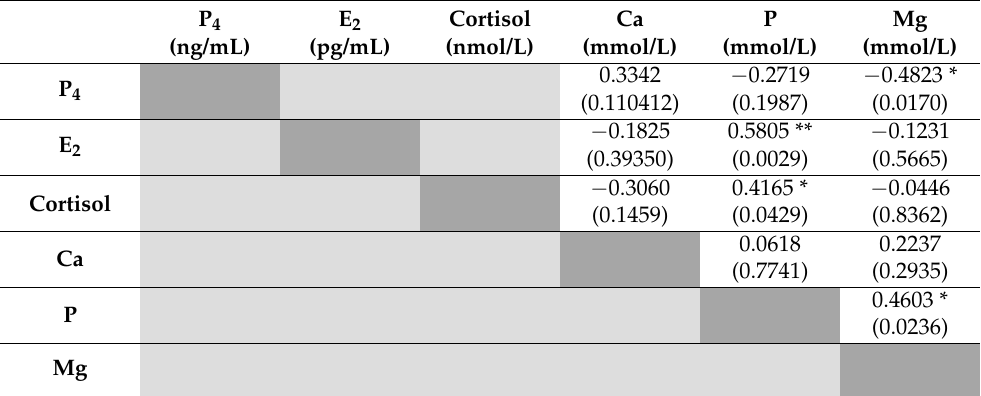
Table 10. Pearson correlation coefficient between steroids hormones, Ca, P and Mg in non-pregnant non-lactating ( n = 14), non-pregnant lactating ( n = 8) and pregnant ( n = 38) she-camels. P 4 E 2 (ng/mL)